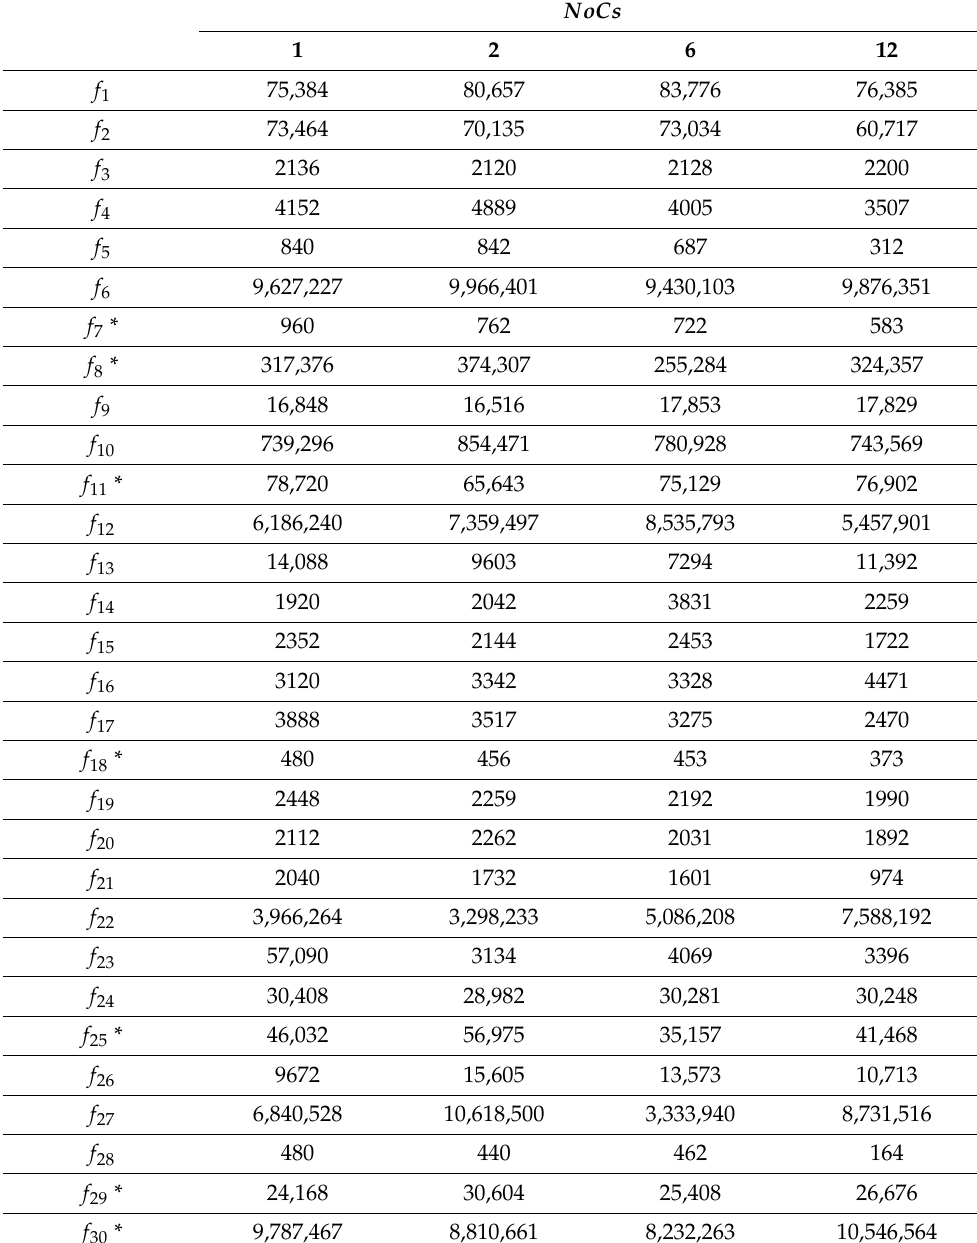
Table 9. Sharing data parallel algorithm: number of function evaluations for error <1 × 10 − 3 (* < 1 × 10 2 ). popInitSize =